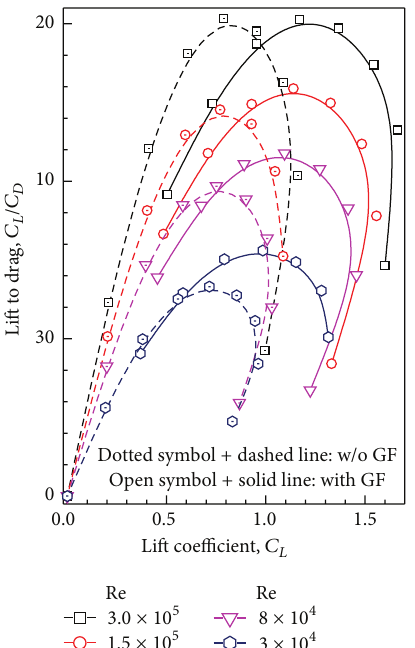
Figure 8: Variation of lift-to-drag ratio with lift coefficient at different Reynolds numbers for the airfoil without and with GF.